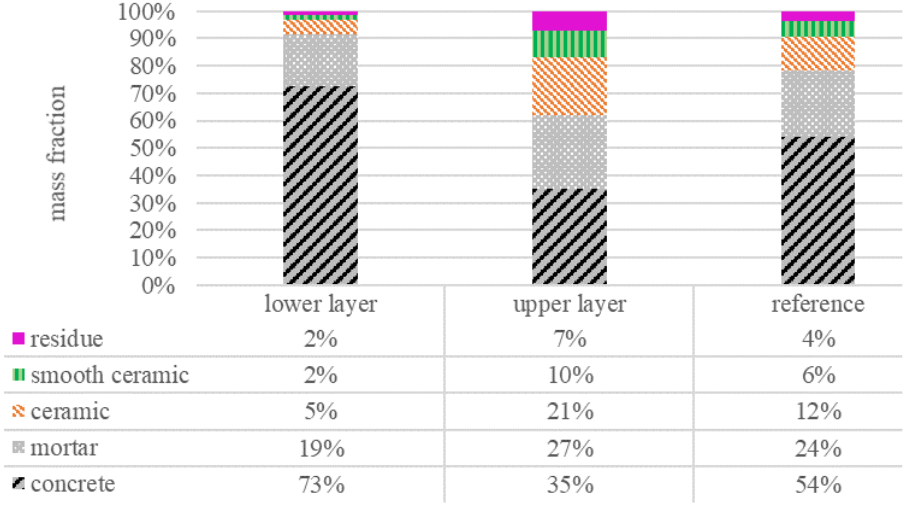
Figure 2. CDW aggregates composition of each